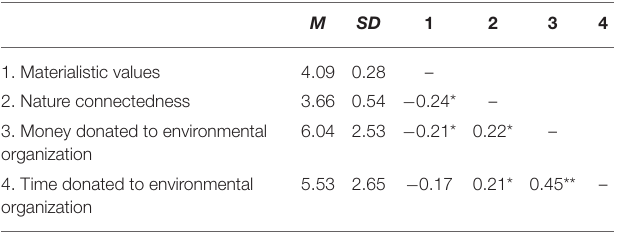
TABLE 3 | Descriptive statistics and intercorrelations between variables in Study